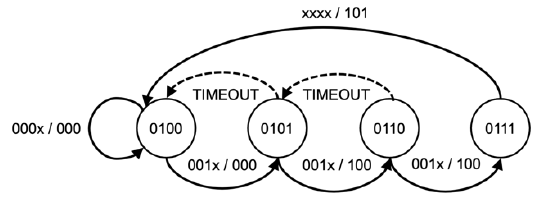
Figure 6. Authentication flood KCSM.